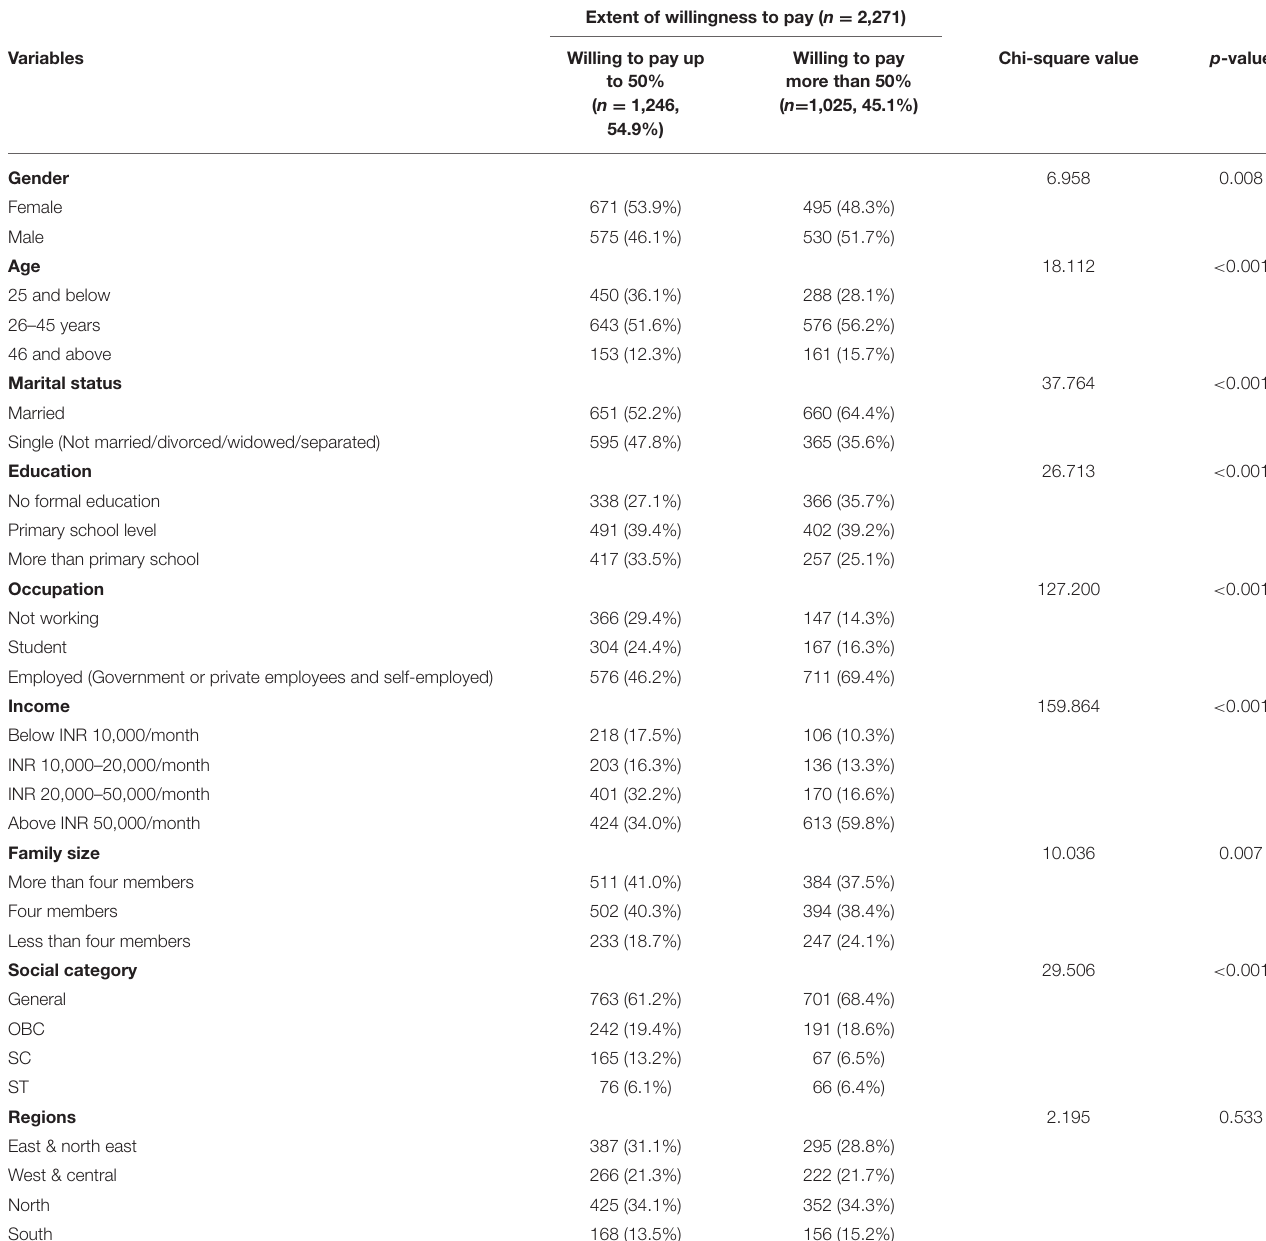
TABLE 4 | Bivariate analysis between sociodemographic characteristics and extent of willingness to pay ( n = 2,271). Extent of willingness to pay ( n =